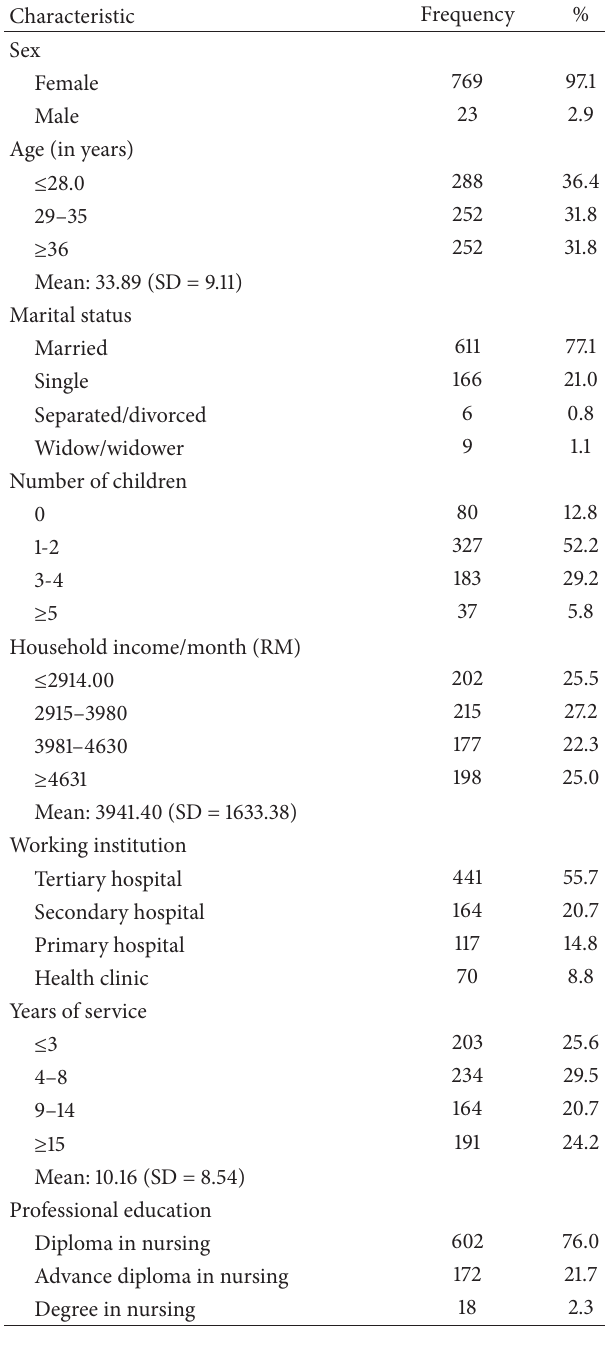
Table 2: Demographic characteristics ( 𝑁 = 792